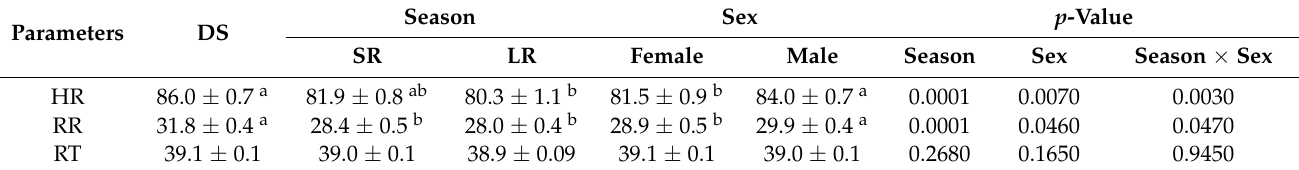
Table 3. Effects of season on physiological parameters of male and female calves (mean ± SE).